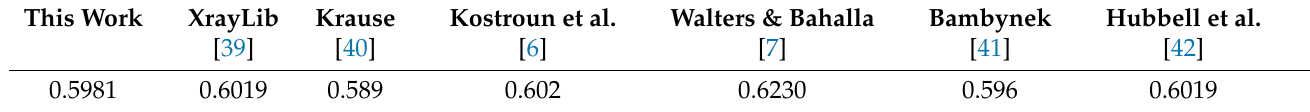
Table 1. K-shell fluorescence yield, ω K .